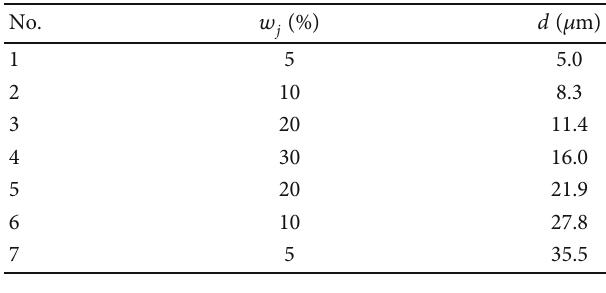
Table 1: The Langmuir-D distribution for MVD = 16 μ m .